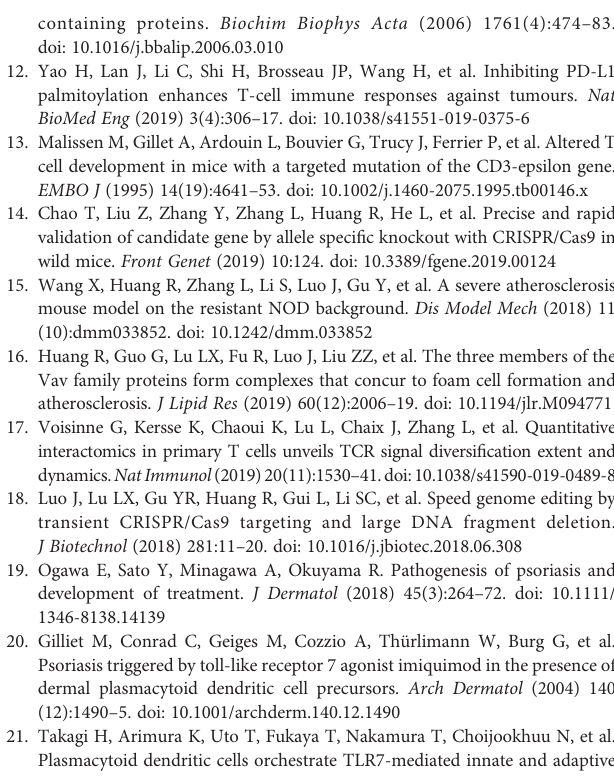
SUPPLEMENTARY FIGURE 1 | Genetic deletion of Zdhhc2 gene in C57BL/6 mice. (A) Schematic diagram of the Zdhhc2 -targeting sgRNA sequences, which were placed in Zdhhc2 exon 3 and intron 3, respectively. Two PAMs sequences are shown in red color. (B) DNA sequencing analysis showed the presence of the intended Zdhhc2 knockoutmutation inF0mice.Thedeletionsize isindicated below theWTsequence.RedletterscorrespondtothePAMsequencesandbluelettersto the sgRNA sequences. The sequence of exon 3 was marked in gray. SUPPLEMENTARY FIGURE 2 | Gating strategy of 4 types of organs of pDC. (A) pDC gating strategy in the skin.After excluding dead cells (DAPI positive), T cells (CD5 + ), B cells (CD19 + ), and macrophages (F4/80 + ), the remaining cells were gated for CD11b - Ly6C + CD317 + as pDCs. (B) pDC gating strategy in the spleen. After excluding dead cells (DAPI positive), T cells (CD5 + ), B cells (CD19 + ), and macrophages (F4/80 + ), the remaining cells were gated for CD11b - Siglec H + CD317 + as pDCs. (C) pDC gating strategy in the DLN. After excluding dead cells (DAPI positive), T cells (CD5 + ), B cells (CD19 + ), and macrophages (CD169 + ), the